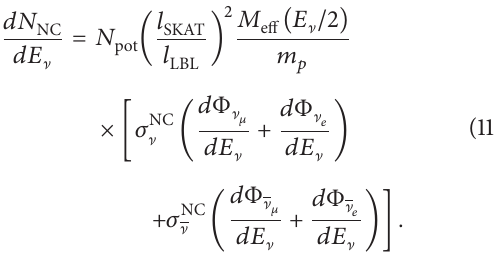
Figure 14: Neutrino flux 𝑑Φ ] /𝑑𝐸 ] per proton as seen by the SKAT bubble chamber. The different lines correspond to the different neutrino